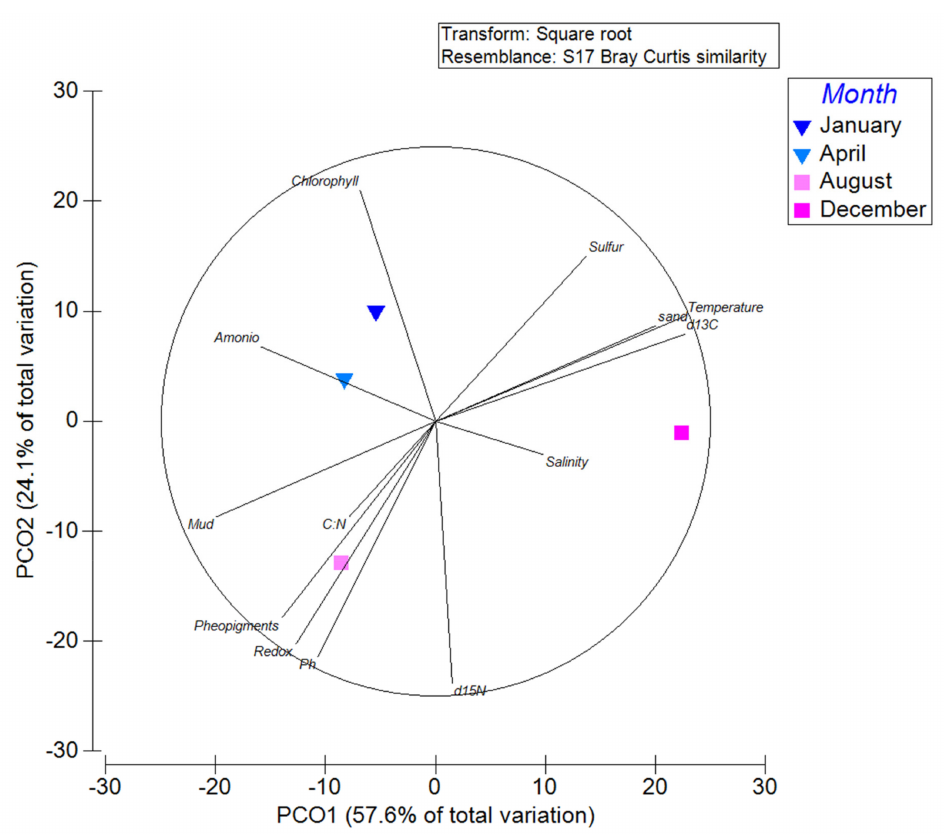
Figure 9. Principal coordinate Analyses showing the pelagic community structure variability associ- ated with the different sampling seasons, and significant correlations with environmental studied